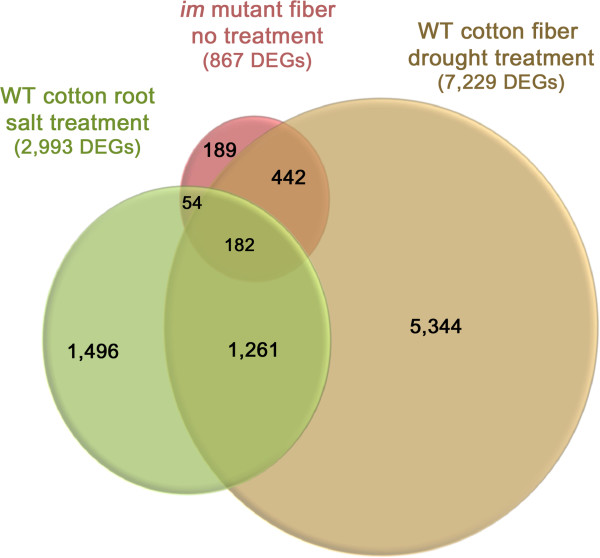
Venn diagrams representing the common DEGs among im mutant fibers without additional stress treatment, wild type cotton roots with salt treatment [32] and wild type cotton fibers with drought treatment [8]. The DEGs showing 2 fold difference (p value ≤0.05) were compared one another.